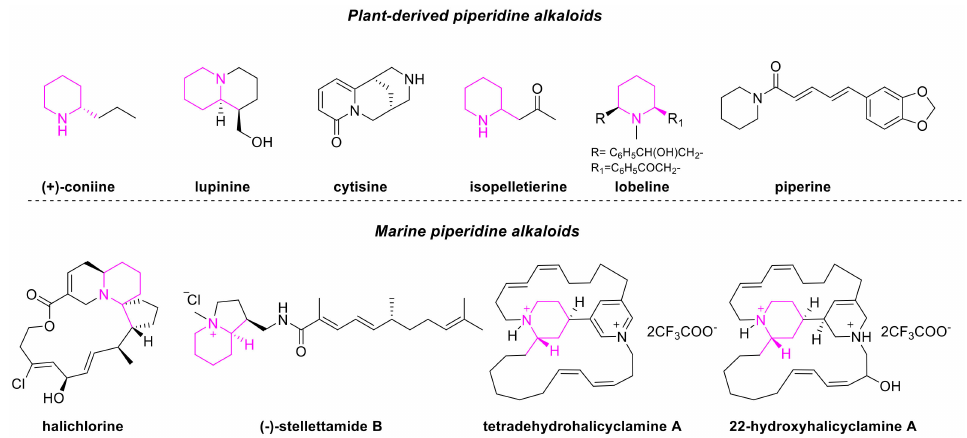
Figure 1. Structures of some representative natural piperidine alkaloids, from vegetal and marine origin. The fundamental α -substituted piperidine sca ff old, shared by some of them, is highlighted in pink.